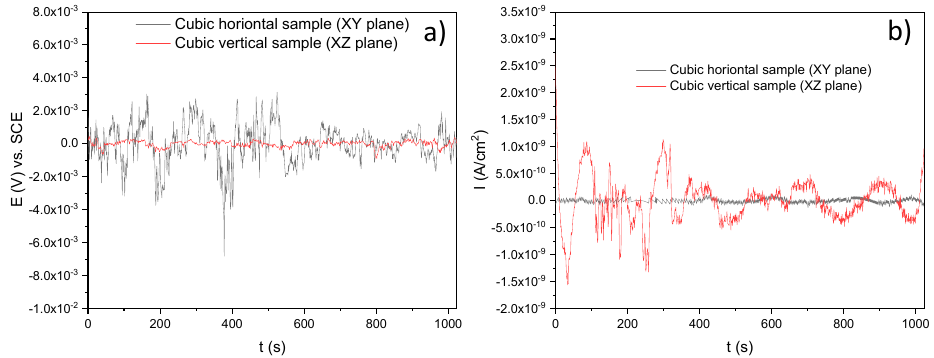
Figure 10. Times series in potential and current for the SLMed 316L SS in H 2 O: ( a ) potential versus time and ( b ) current versus time.